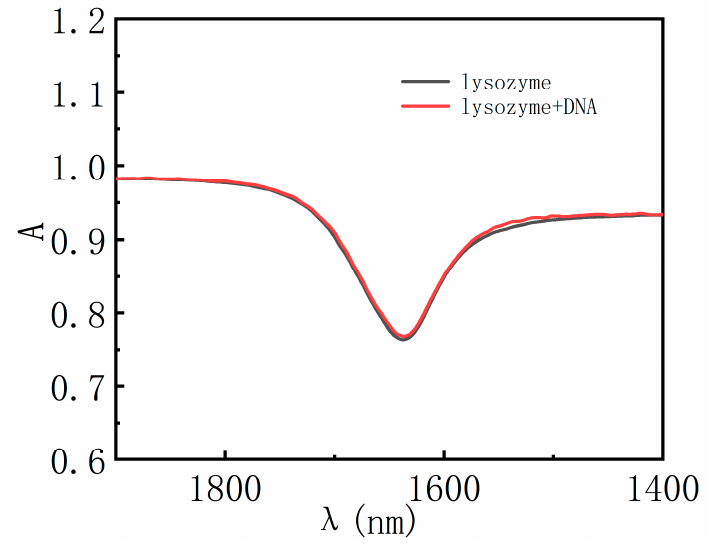
Figure 8. FT-IR spectra of lysozyme and lysozyme–DNA.